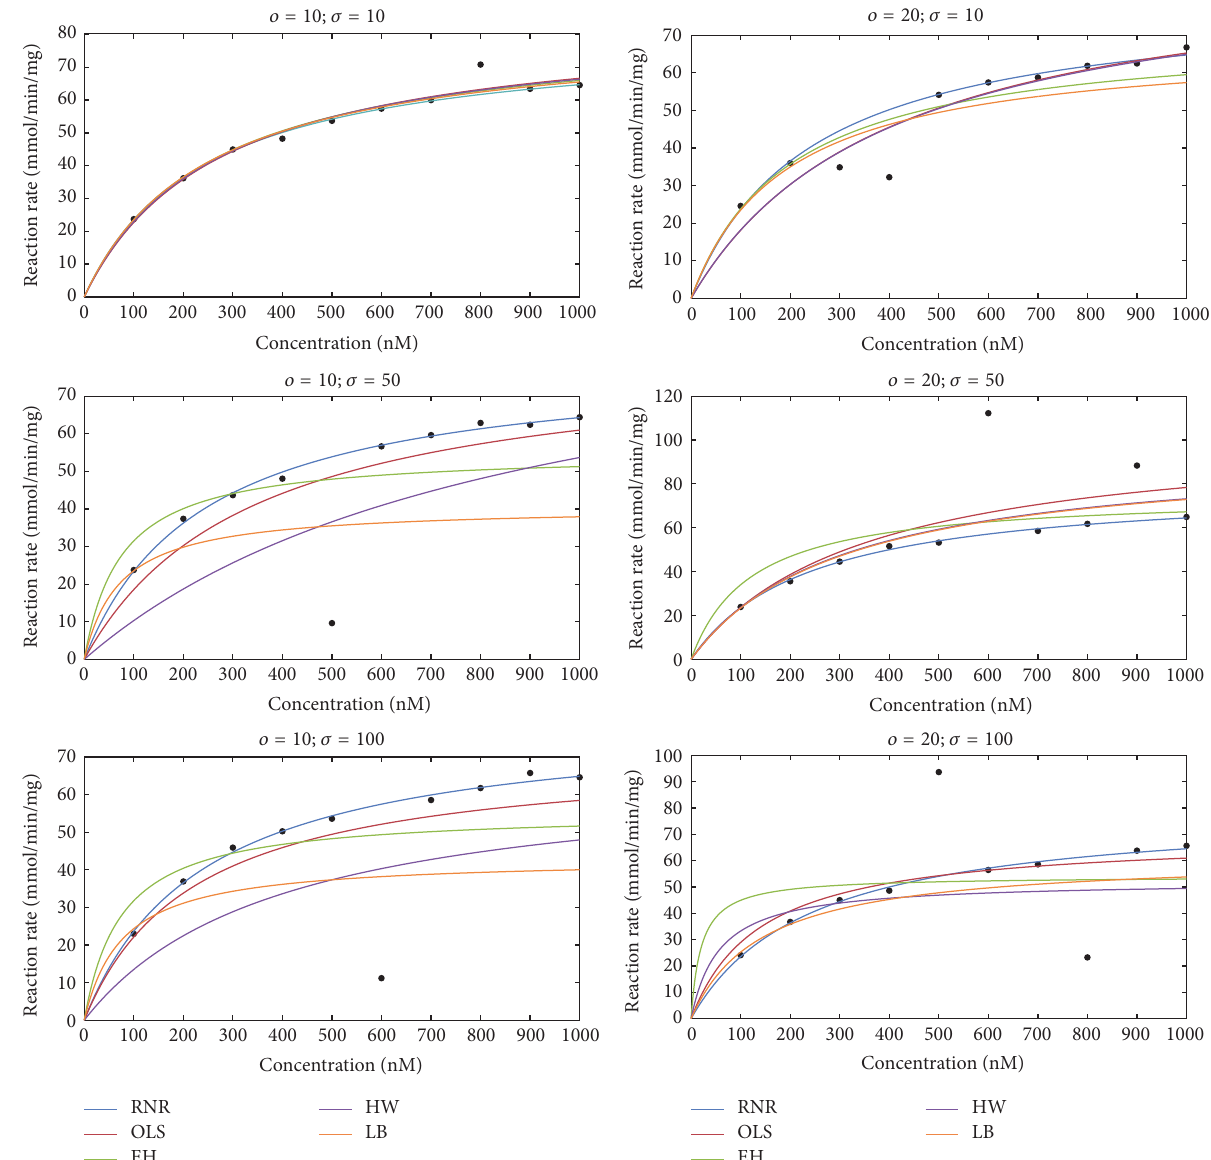
Figure 6: Curves fitted using different fitting techniques for random replications of situations